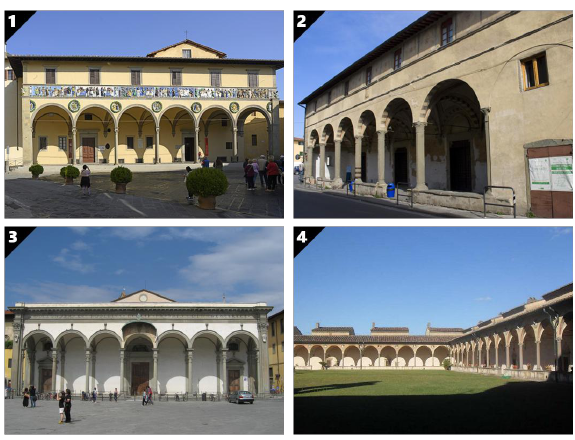
Figure 1 . The first four building of the dataset.